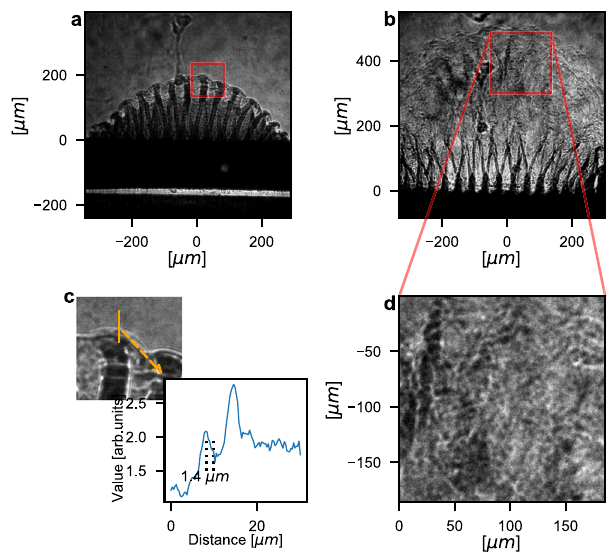
Fig. 2 Experimental radiographs of the mono-mode targets. Experimental radiographs of mono-mode targets obtained before (40 ns ( a ) and ( c )) and after (60 ns ( b ) and ( d )) the transition to turbulence between 50 and 60 ns. Following the initial Rayleigh – Taylor growth and pusher expansion (curved modulated surface of the two fi rst radiograph), the system becomes turbulent. The structure becomes blurry and the power spectrum nearly isotropic, as can be observed on the zoom of the 60 ns radiograph. A precise study was made possible thanks to the high resolution of the radiography, which is illustrated on the zoom and line-out of the 40 ns radiograph ( c